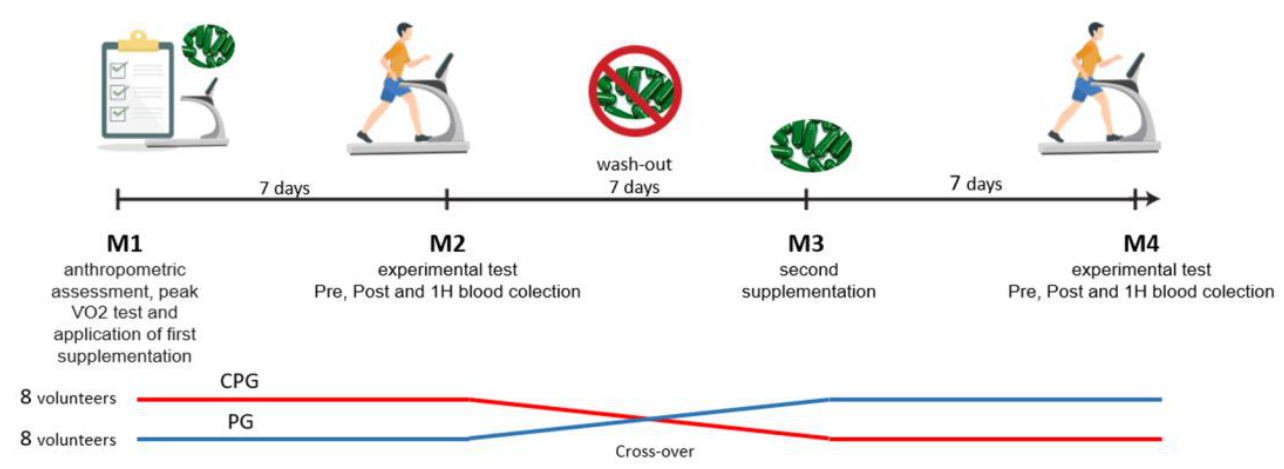
Figure 1. Experimental